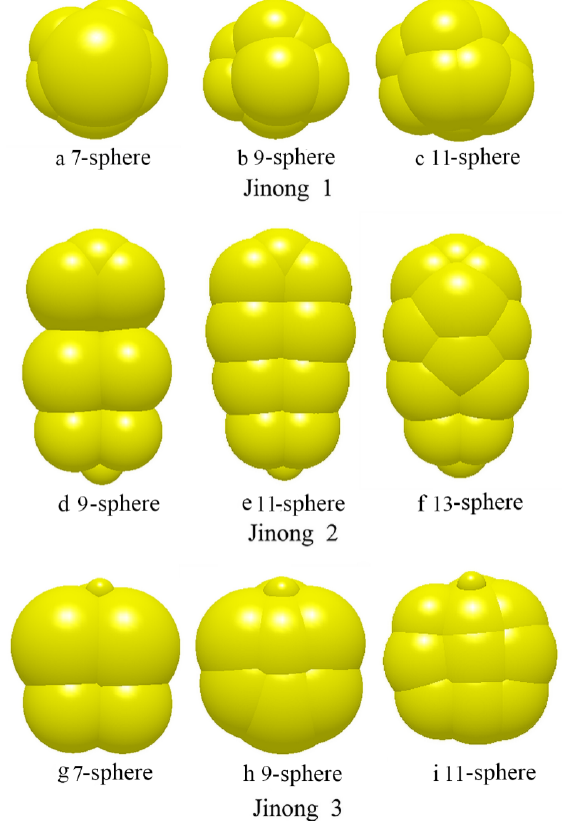
Figure 13. ( a – c ) Filing methods for the multi-sphere model of Jinong 3.